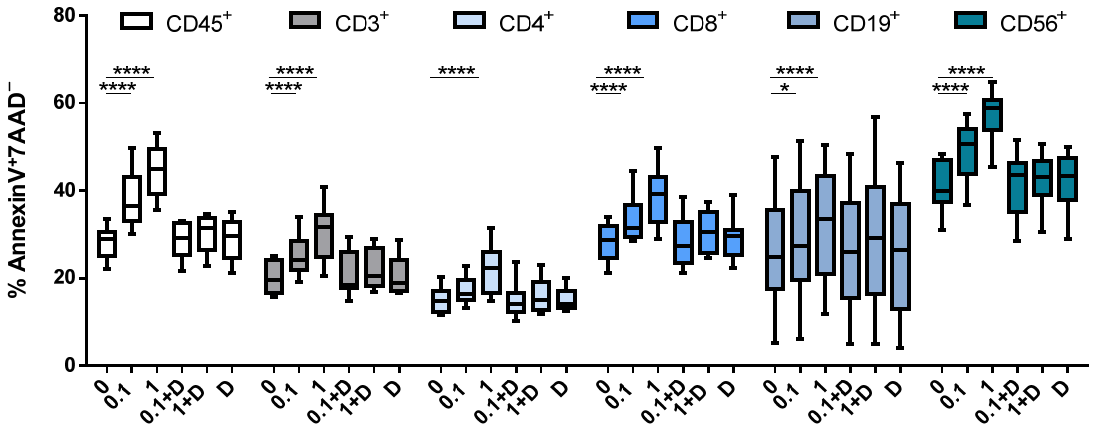
Figure 3. Effect of cladribine on apoptosis of PBMCs. Isolated PBMCs were stimulated with 5 µ g/mL PHA and treated with no cladribine, 0.1 or 1 µ M of cladribine, in the presence or absence of 250 µ M of deoxycytidine, for 16 h. Percentages of gated CD45 + , CD3 + , CD4 + , CD8 + , CD19 + and CD56 + that show positivity for Annexin V and negativity for 7AAD are represented. Gating strategy for this experiment is shown in the Supplementary Figure S2. One-way ANOVA with repeated measures followed by Dunnett’s multiple comparisons test was performed, comparing every mean value to a control untreated group mean (0 group). * p -value < 0.05, **** p -value < 0.0001. ( N = 10). Cladribine concentrations ( µ M) are plotted on the x axis. D: deoxycytidine.